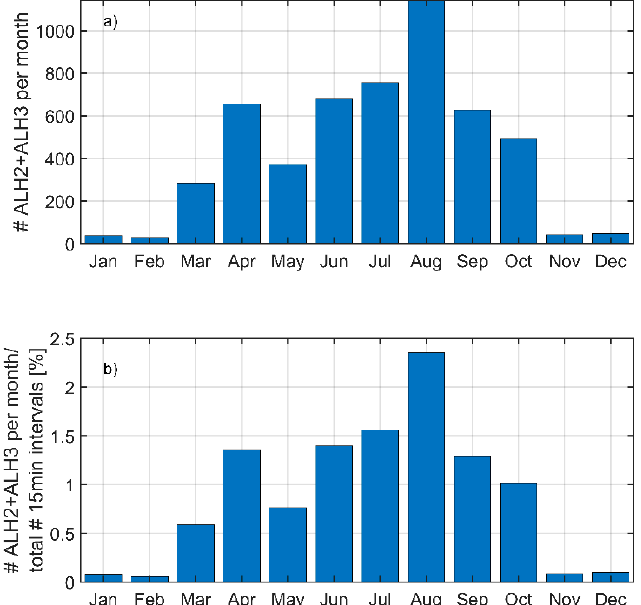
Figure 8. ( a ) Number of events (ALH2 + ALH3) recorded for each month. ( b ) Number of events per month normalized by the total number of 15 min intervals over the three-year period.